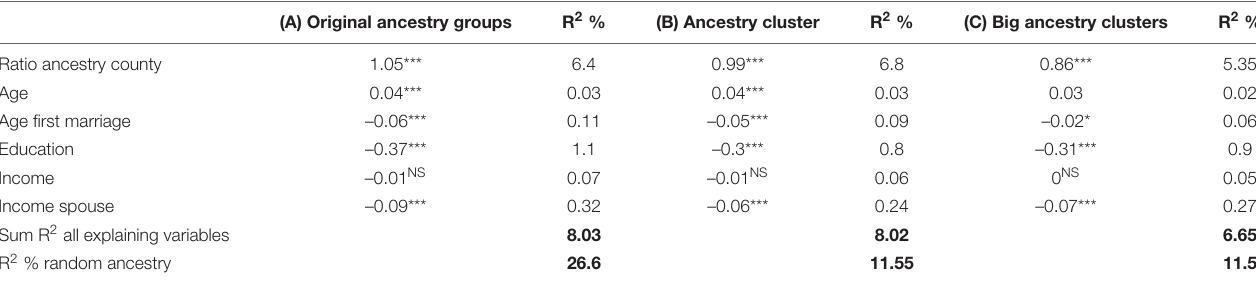
TABLE 5 | Being in an ancestral heterogamous relationship vs. a homogamous relationship regressing on the ratio of the same ancestral group in a county, age, age at first marriage, education, income, spouse’s income, R 2 for each explaining variable, the sum of R 2 of all explaining variables, and R 2 of the random factor ancestry.